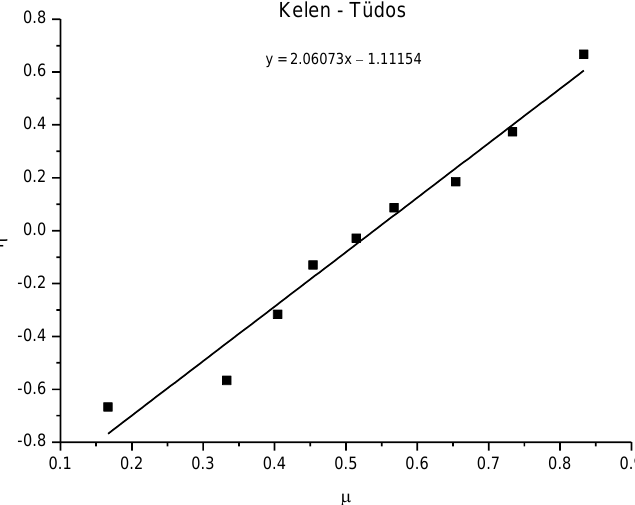
Figure 13. η versus µ plot for monomer reactivity calculation; r 1 = 0.9492, r 2 = 1.1115. After linear regression, the straight line provided r 1 when µ = 1 and r 2 when µ = 0. The values obtained by this method were similar to those obtained by the Fineman – Ross